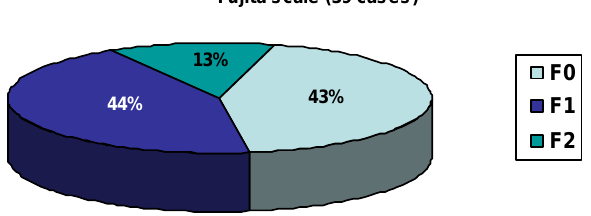
Fig. 11. Tornadoes path length distribution (1980–2009). Only Figure 11. Tornadoes path length distribution (1980-2009). Only those cases with reliable those cases with reliable information sources have been considered. information have been considered.